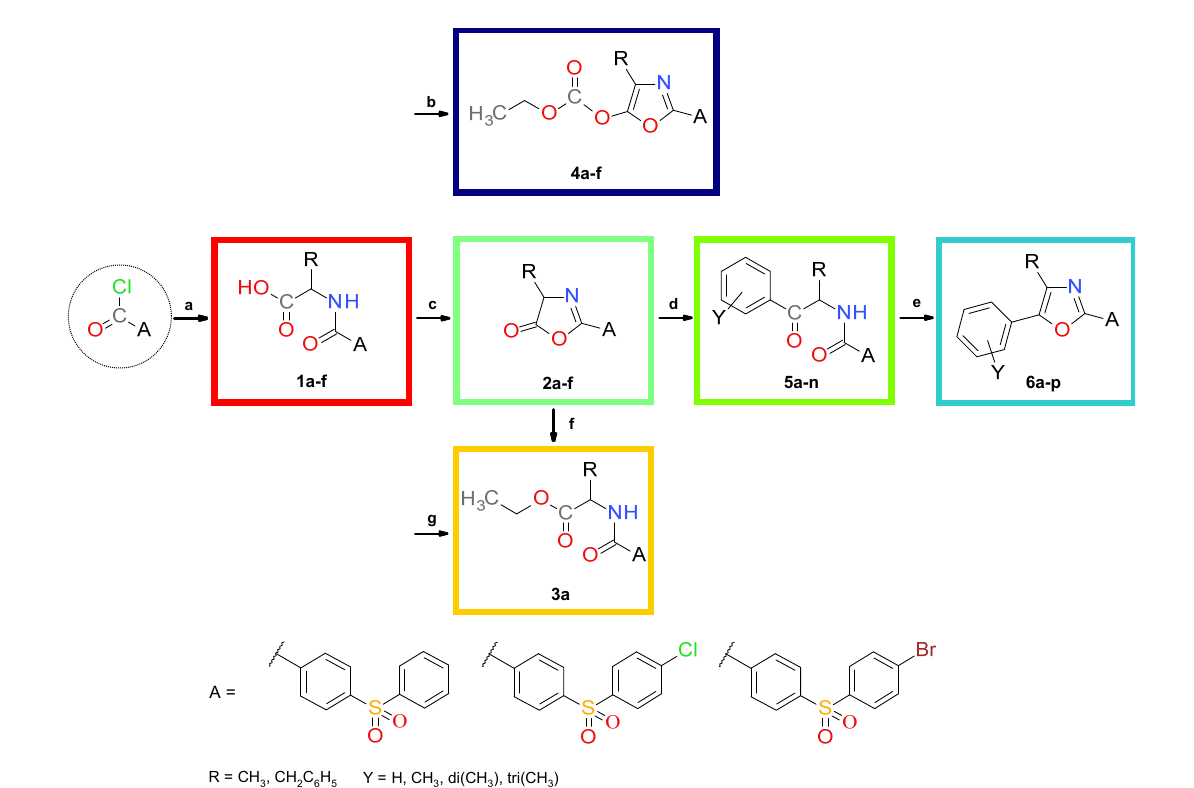
Scheme 1. The general synthetic methodology as described in our previous papers [59–65]. Reagents and conditions: ( a ) (i) alanine or phenylalanine/NaOH, CH 2 Cl 2 , 0–5 °C, 30 min; (ii) room temperature